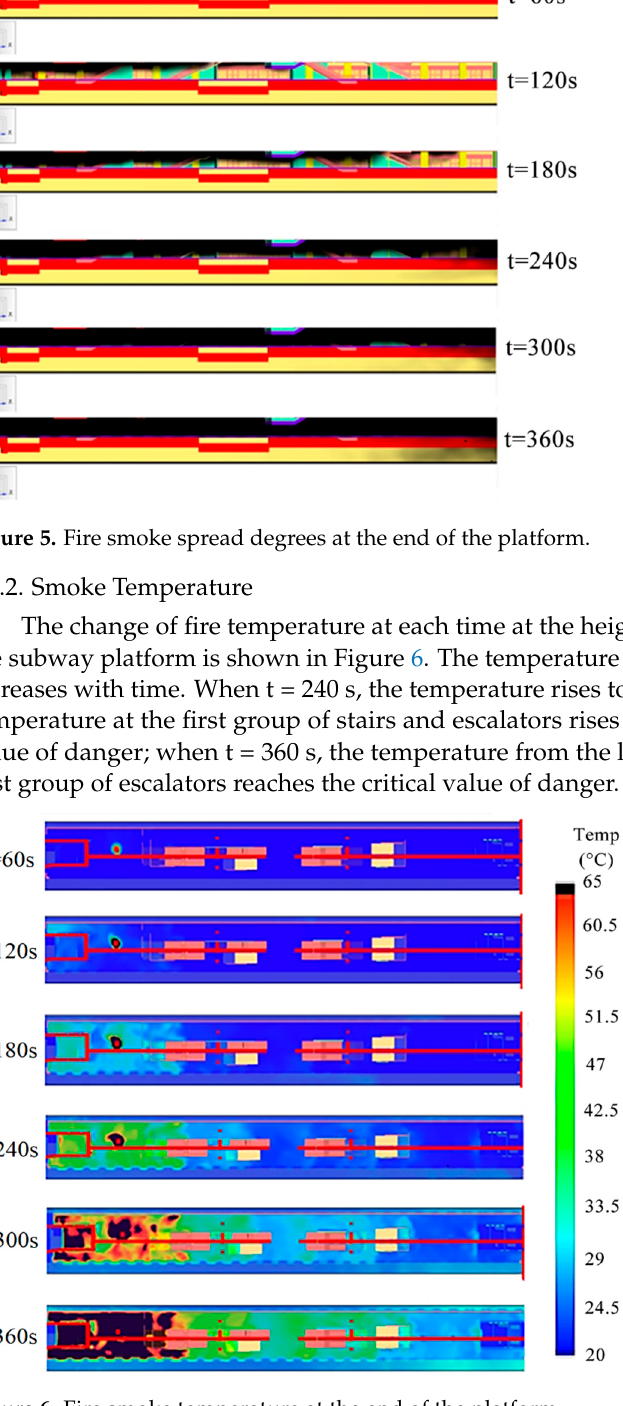
Figure 6. Fire smoke temperature at the end of the